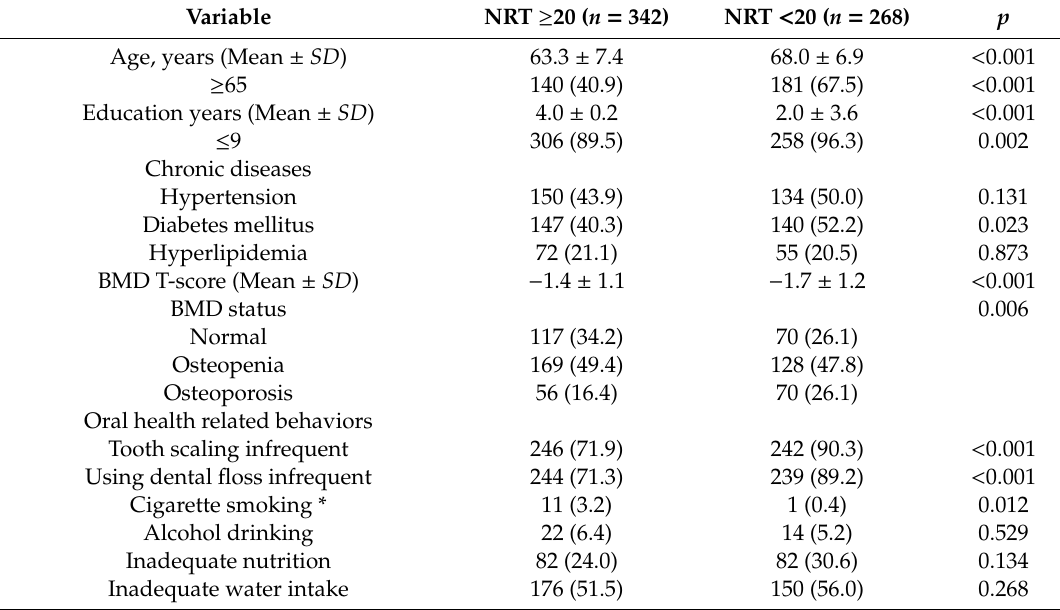
Table 2. Univariate analysis of factors associated with number of remaining teeth (N =